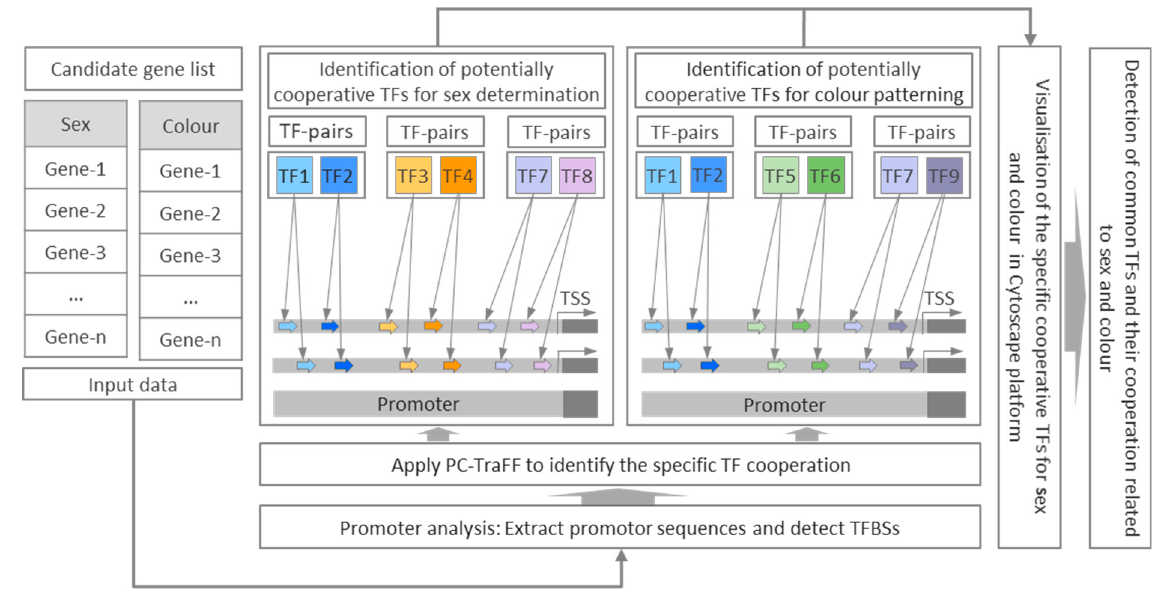
Figure 1. Workflow of analysis used in this study for identification of TF pairs based on their predicted binding sites for sex determination and colour pattern genes in zebrafish with respect to phenotypic divergence. The potential schematic cooperation between TF pairs illustrating that TF1–TF2 pairs are common to both phenotypes (sex and colour), TF3–TF4 pairs are specific to sex determination, TF5–TF6 pairs are specific to colour pattern, TF7–TF8 and TF7–TF9 pairs switch their partners in different phenotypes, where TF7 is a common single TF for both phenotypes. TF: transcription factor, TSS: transcription start site, TFBSs: transcription factor binding sites.